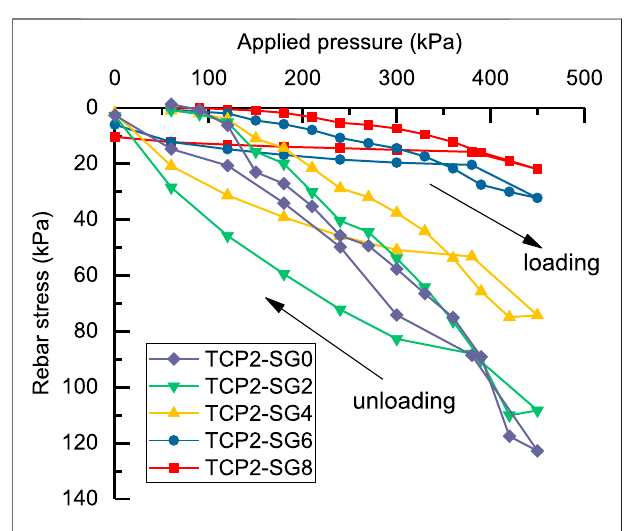
FIGURE 5 | Stress variation in the steel rebar of TCP2 under static load